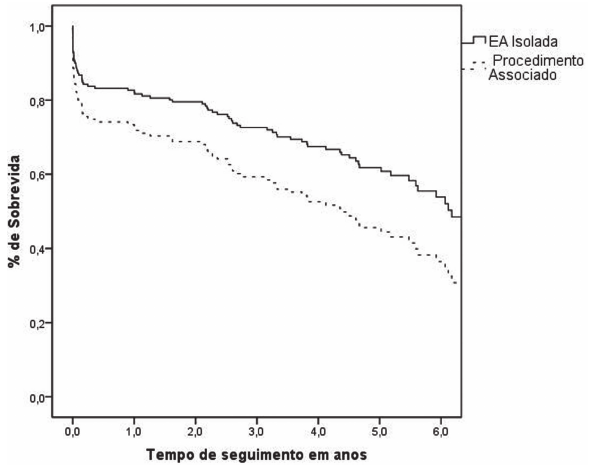
Fig. 2. Curva de Kaplan-Meier de sobrevida atuarial, de acordo com o período de tempo estudado. EA = estenose